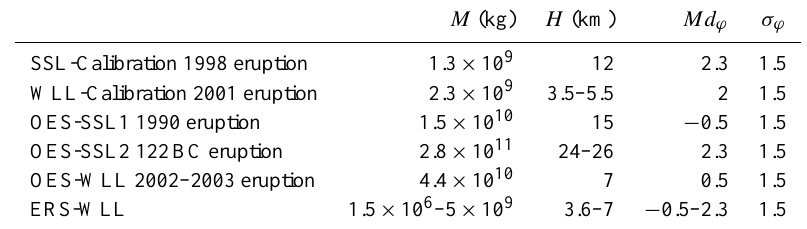
Table 1. Eruption source parameters used in the hazard assessment: M is the total mass, H the column height and Md ϕ and σ ϕ are mode and standard deviation of the